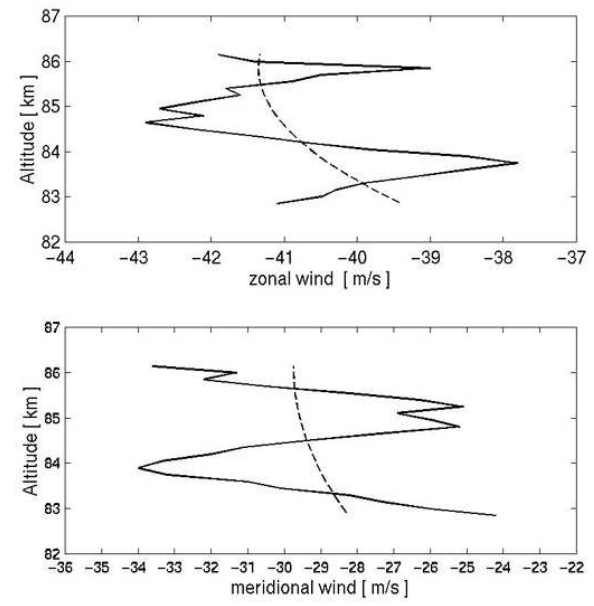
Fig. 8. Hodograph analysis of horizontal wind velocity disturbances with 150-m resolution at 22:35 UT on 10 August